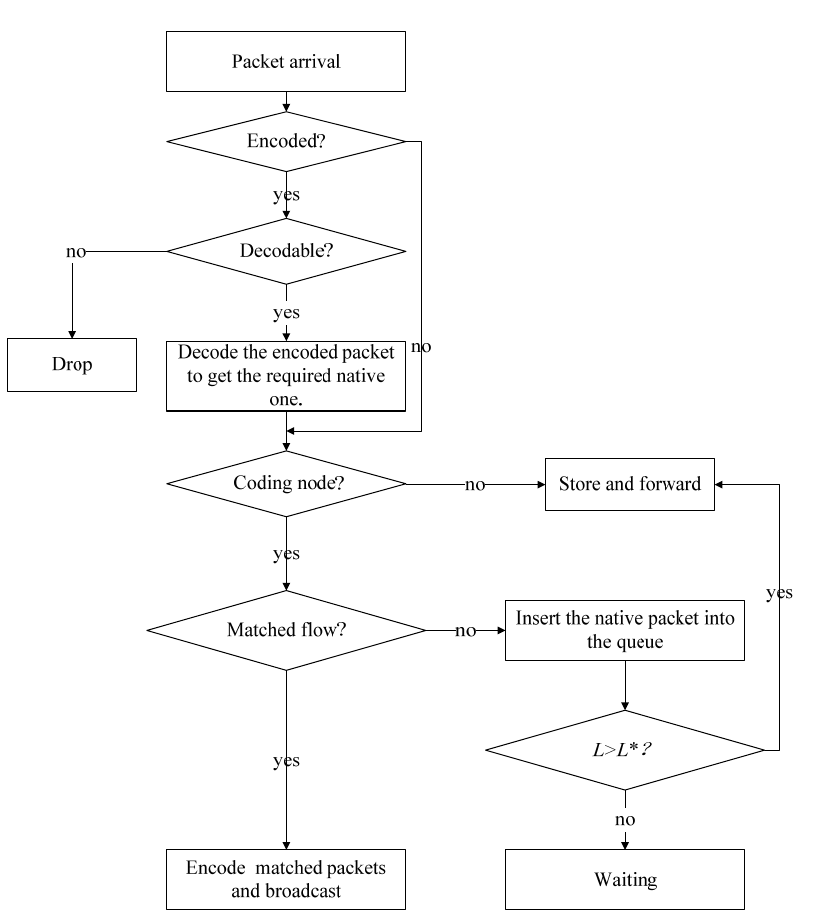
Figure 6. Flow chart for data transmission of intermediate nodes in our proposed